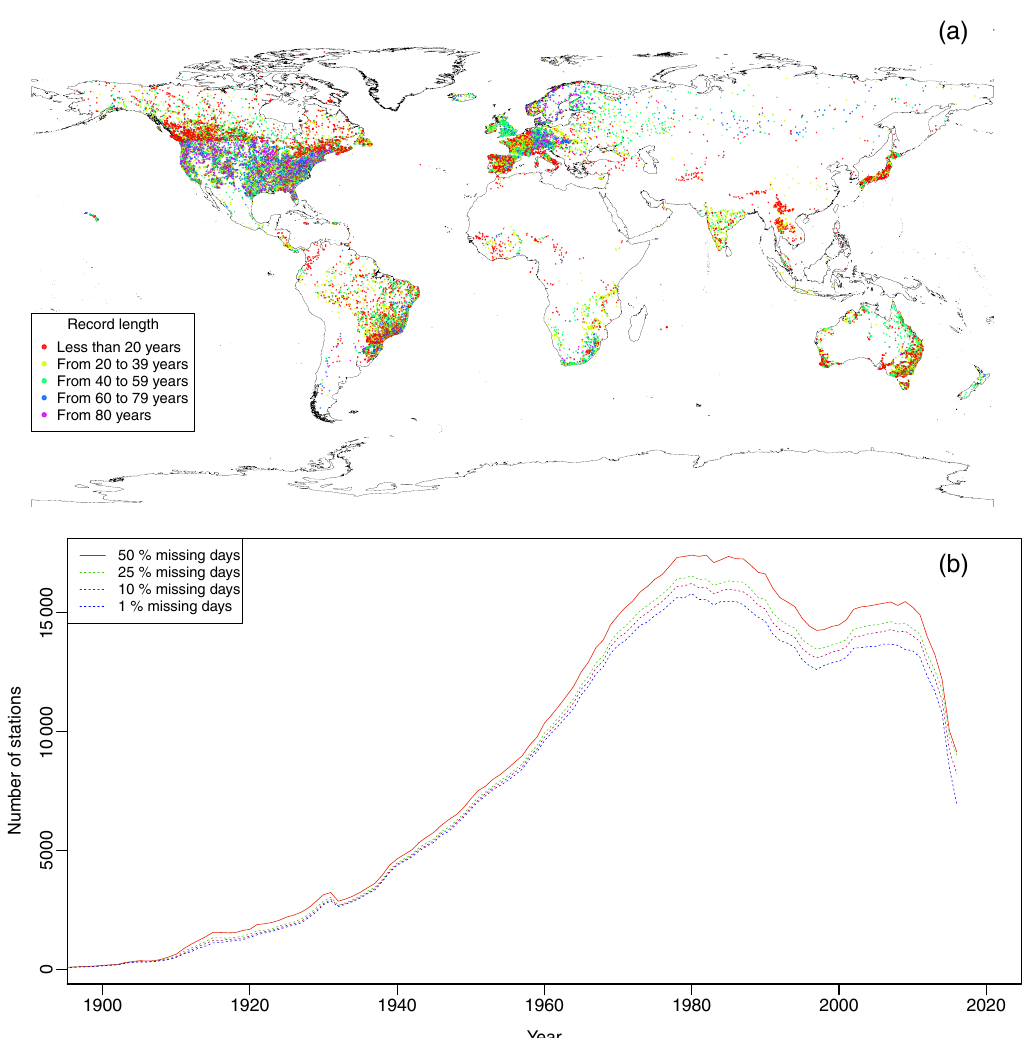
Figure 5. Availability of GSIM time series. (a) illustrates the length of record at each station, and (b) illustrates the number of available time series over time for four different missing data